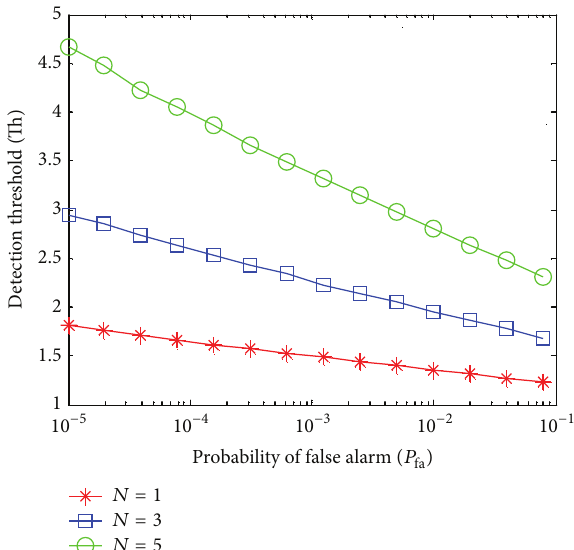
Figure 3: Detection threshold versus probability of false alarm at different carrier numbers.